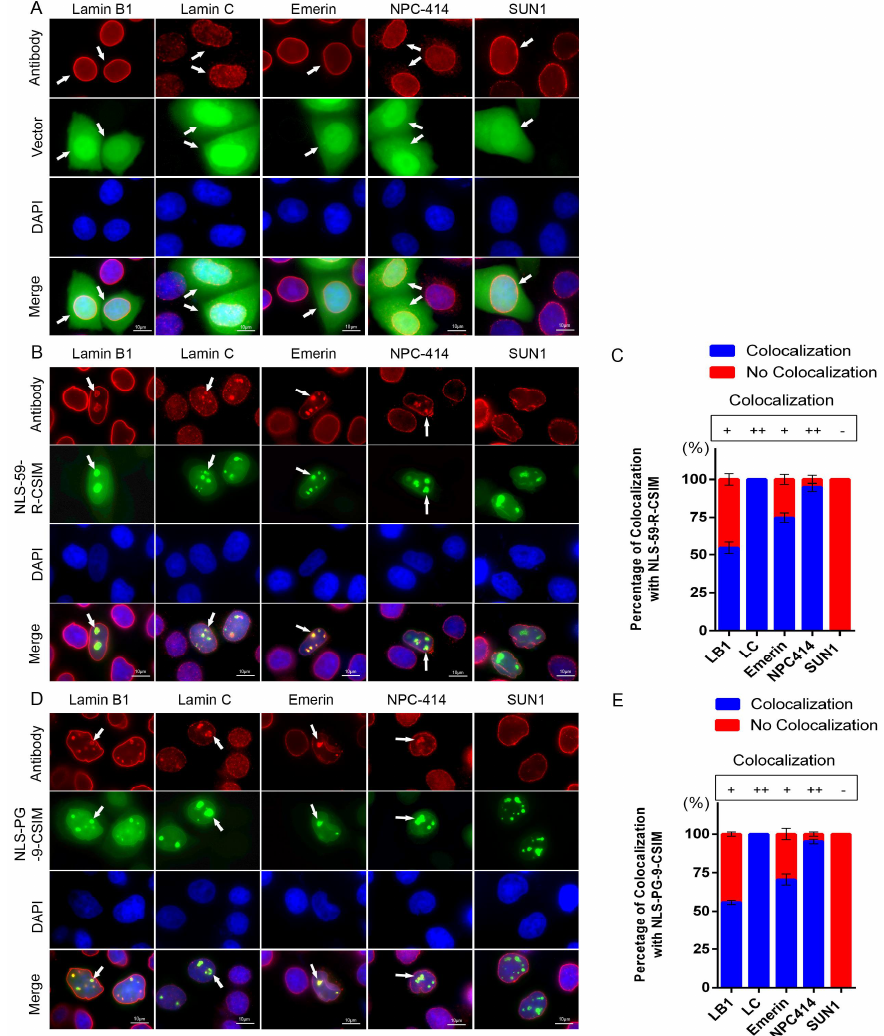
Figure 3. Disorganized distributions of NE proteins. ( A ) Immunocytochemistry was performed on EGFP vector-, ( B ) EGFP–NLS-59-R-CSIM- and ( D ) EGFP–NLS-PG-9-CSIM-transfected HeLa cells. In panels A , B , and D , cells were stained with anti-lamin B1, lamin C, emerin, NPC-414, and SUN1 antibodies. Chromatin was stained with DAPI. Representative images of lamin B1, lamin C, emerin, NPC-414, and SUN1 staining in the indicated cells. Colocalization of lamin B1, lamin C, emerin, and NPC-414 with EGFP signals at the NE and NE invaginations are as indicated with arrowheads. Scale